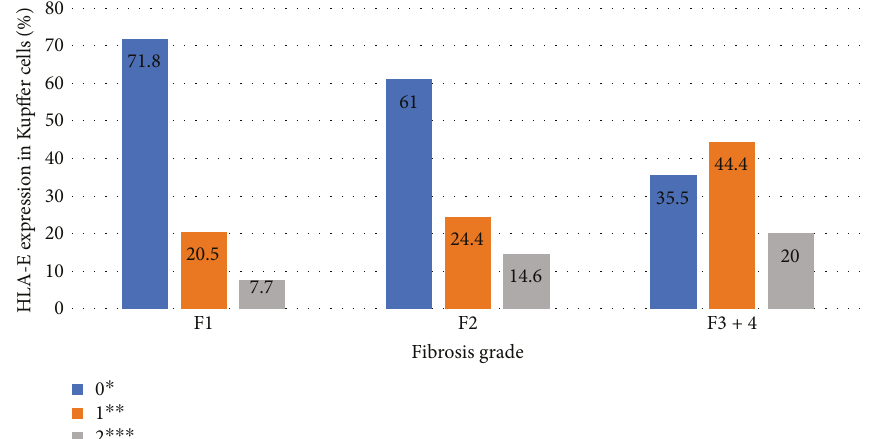
Figure 4: Association between HLA-E expression in Kup ff er cells and liver fi brosis. HLA-E expression was described in the following grades: 0 ∗ (without positive cell expression), 1+ ∗∗ ( < 25%), 2+ ∗∗∗ (25 – 50%). There was no grade 3+ expression in this case. Fibrosis was described according to the METAVIR classi fi cation: F1: portal fi brosis without septa, F2: portal fi brosis with rare septa, F3-4: numerous septa without and with cirrhosis. P = 0 02